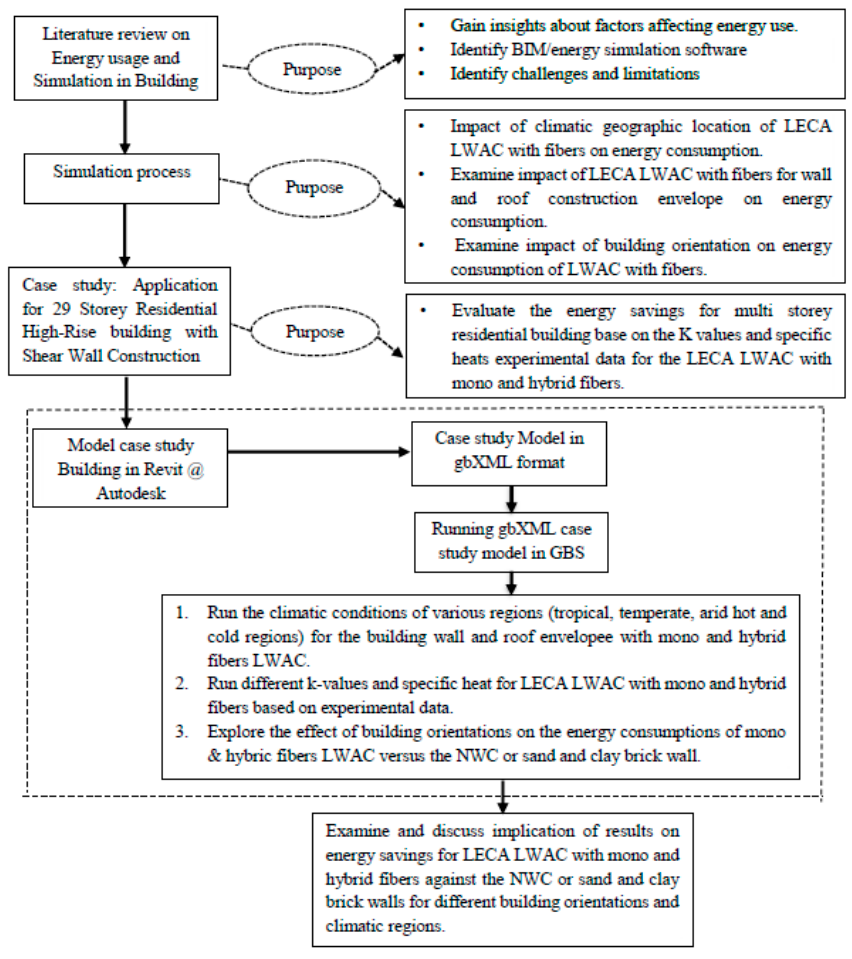
Figure 1. Summary of the energy simulation research framework for fibre-reinforced LECA-LWAC.